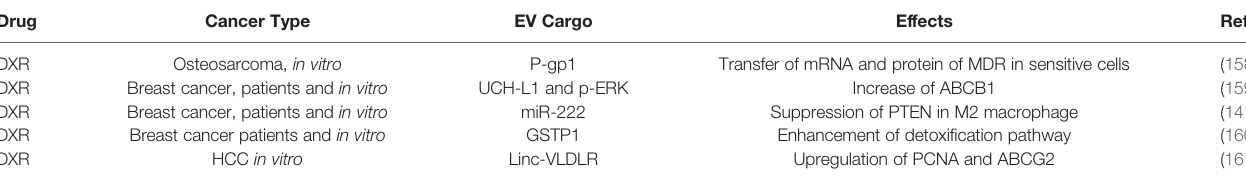
TABLE 3 | Resistance to doxorubicin (DXR) mediated by EVS.